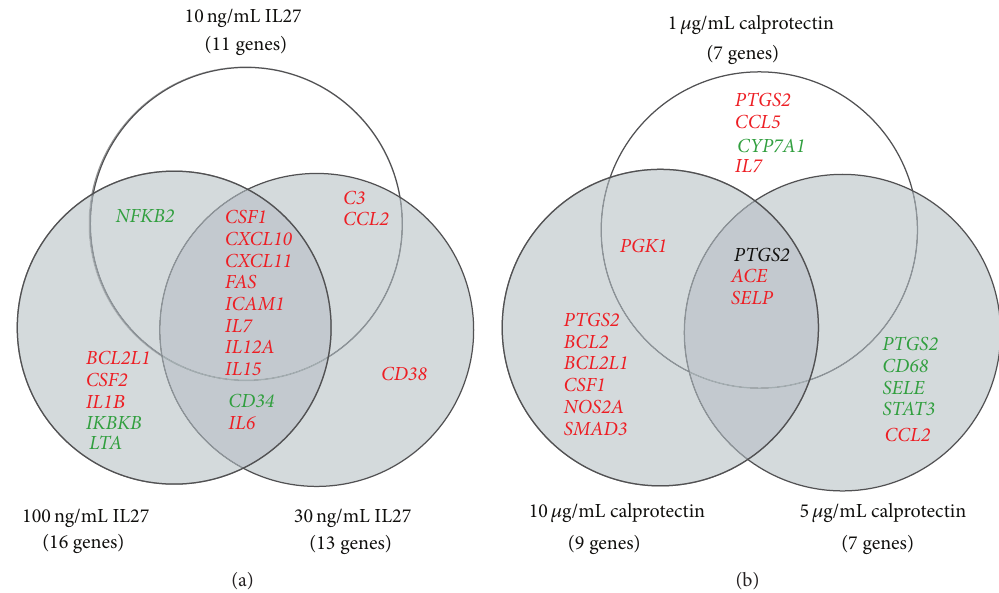
Figure 1: Venn diagrams on IL27- and calprotectin-stimulated HUVECs including significant regulated genes with 𝑝 value 𝑝 < 0.05 : red: upregulated, green: downregulated, and black: up- and downregulation different in compared concentrations. (a) Venn diagram: HUVECs stimulatedwithIL27(10,30,and100 ng/mL).(b)Venndiagram:HUVECsstimulatedwithcalprotectin(1,5,and10 𝜇 g/mL).ACE,angiotensin- converting enzyme; BCL2, B-cell lymphoma 2; BCL2L1, BCL2-like 1; C3, complement component 3; CD, cluster of differentiation; CSF, colony stimulating factor; CCL2/MCP-1, monocyte chemotactic protein-1; CCL5/RANTES, regulated on activation, normal T cell expressed and secreted; CXCL10, interferon gamma-induced protein 10; CXCL11, interferon-inducible T cell alpha chemoattractant; CYP7A1, cholesterol 7 alpha-hydroxylase;FAS,Fascellsurfacedeathreceptor;ICAM1,intercellularadhesionmolecule1;IKBKB,inhibitorofkappalightpolypeptide gene enhancer in B-cells, kinase beta; IL, interleukin; LTA, lymphotoxin- 𝛼 ; NFKB2, nuclear factor-kappa-B p100 subunit; NOS2A, inducible nitric oxide synthase; PGK1, phosphoglycerate kinase 1; PTGS2, prostaglandin G/H synthase and cyclooxygenase; SELE, selectin E; SELP, selectin P; SMAD3, mothers against decapentaplegic homolog 3; STAT, signal transducers and activators of